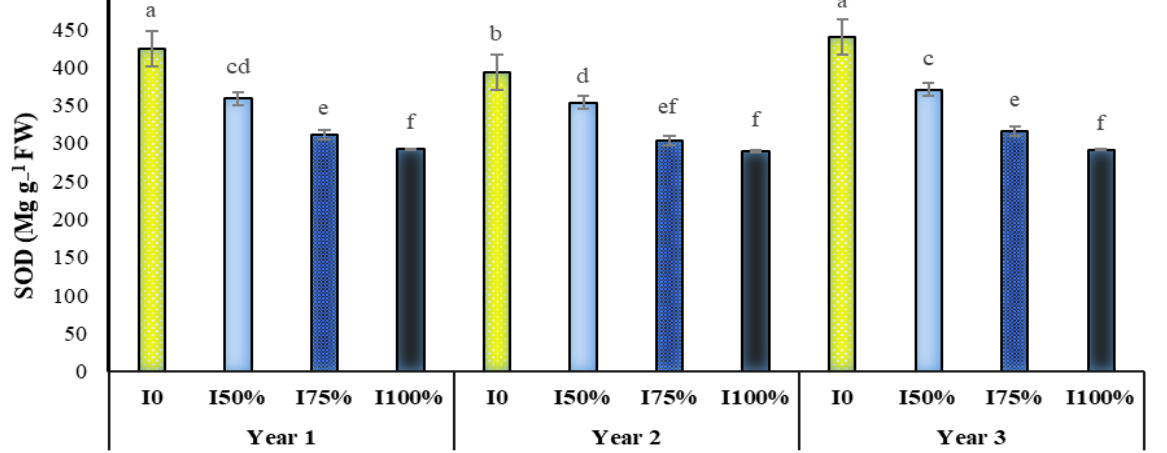
Figure 2. Dual interaction of experimental years (2016–2017, 2017–2018 and 2018–2019) and different levels of irrigation (I0 = no irrigation, I50% = 50%, I75% = 75% and I100% = 100% water requirement of the plant) on the activity of superoxide dismutase (SOD) enzyme in A. hirtifolium . Columns designated by the same letter are not significantly different at the p ≤ 0.05 level as determined by the LSD test.